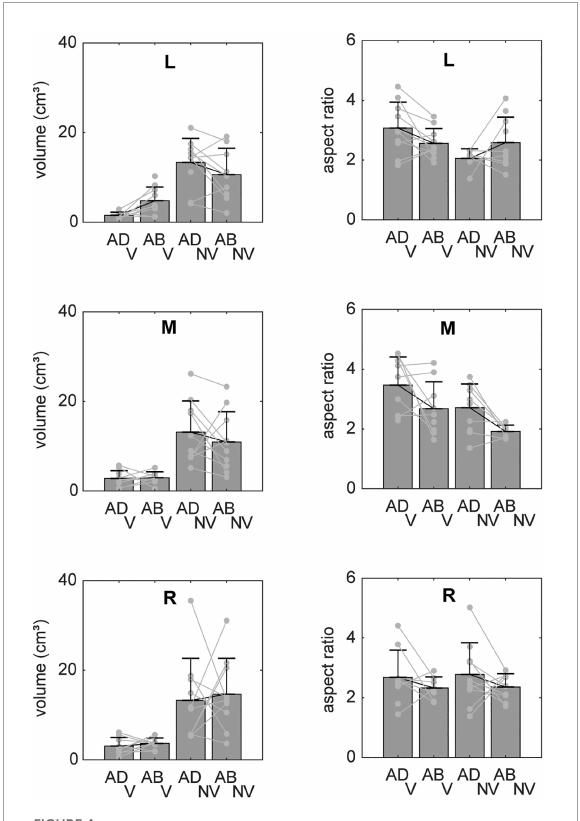
FIGURE4 Average volumes and aspect ratios ( ± SD) for reaches to each target. Individual participant data (light gray lines) are superimposed on each set of bars. Volumes were generally much larger in the NV condition and also appeared to show a dependence on arm posture, though the nature of these postural effects varied between visual conditions and across targets. Aspect ratios showed less of a dependence on visual condition but also varied with initial arm posture in a manner that differed across targets and between visual